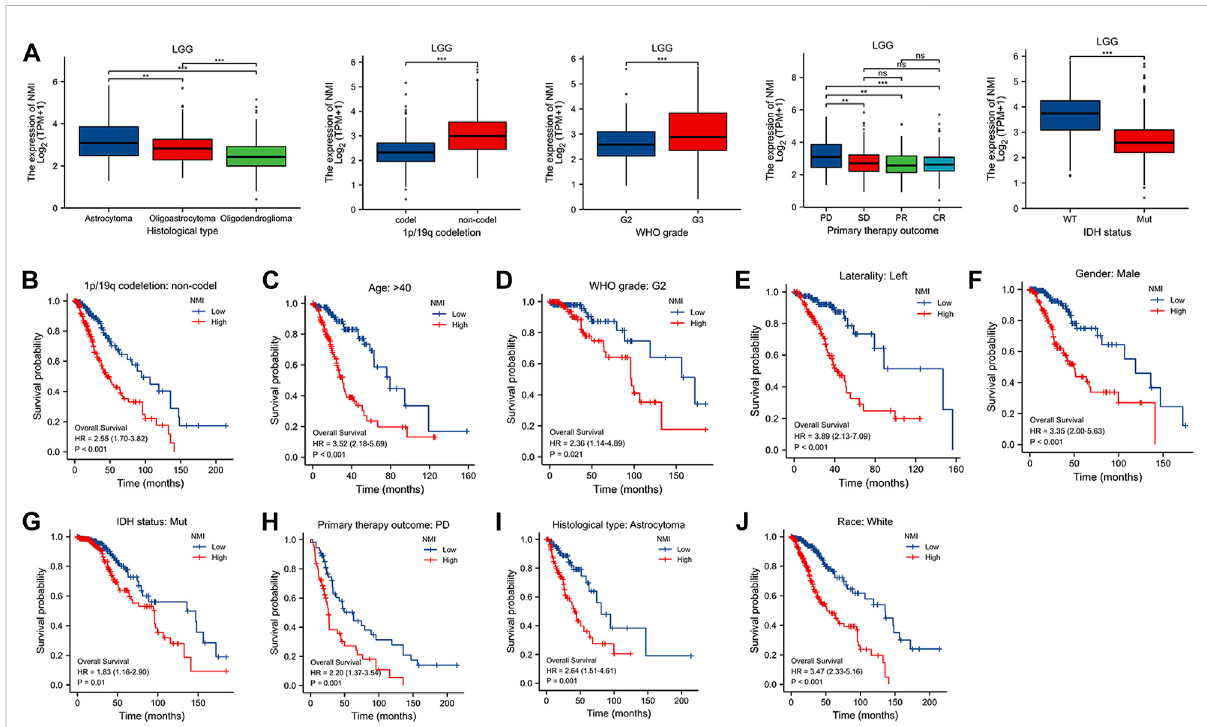
FIGURE 7 (A) Correlation between NMI and clinical features of LGG patients. ** p < 0.01, *** p < 0.001. ns, not signi fi cant. (B – J) The relationship between the expression of NMI and OS in different clinical subtypes of LGG. (B) 1p/19q codeletion: non-codel, (C) age > 40, (D) WHO grade: G2, (E) laterality: left, (F) sex: male, (G) IDH status: mutation, (H) primary therapy outcome: PD, (I) histological: astrocytoma, (J) race: white.